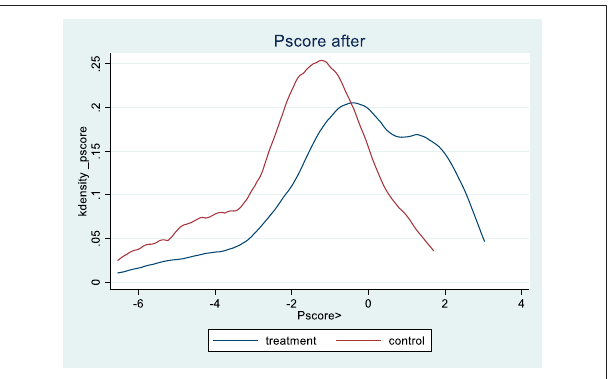
FIGURE 3 | Kernel density of the treatment group and control group after the